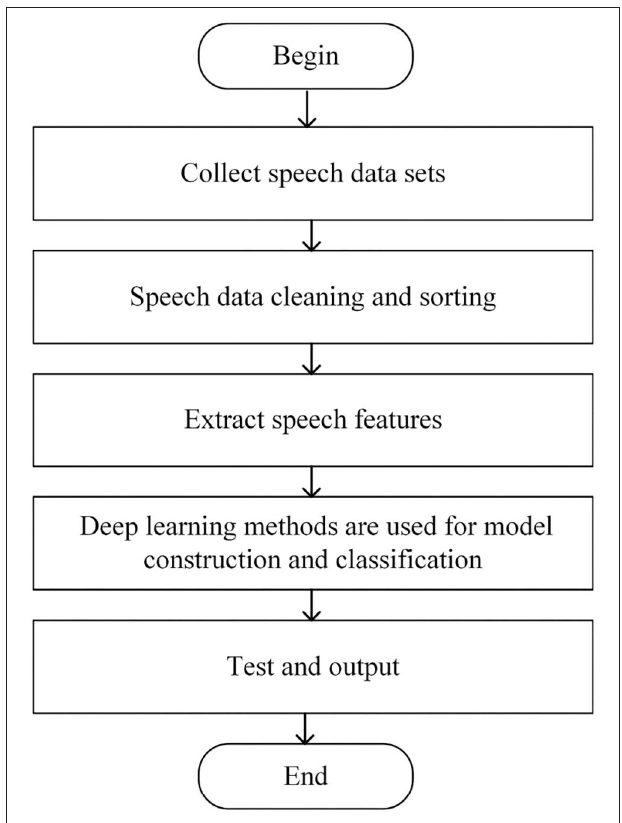
FIGURE 2 | Flow chart of depression